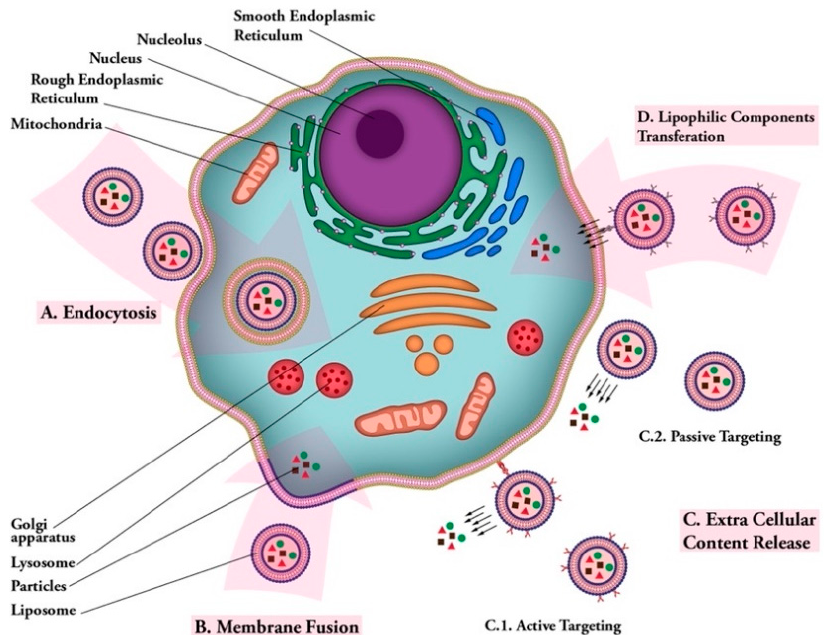
Figure 4. Liposomal vaccine uptake mechanisms. ( A ) Endocytosis: uptake of vaccine carrier by cell; ( B ) membrane fusion: fusion of vaccine carrier and cell membranes and release of vaccine particles into cytoplasm; ( C ) extra cellular content release: ( C.1 ); active targeting: releasing vaccine particles near cell membrane after targeting via ligand-receptor connection. ( C.2 ); passive targeting: release of vaccine particles near cell membrane; ( D ) lipophilic components transferation: transfer of lipophilic vaccine particles through cell membrane after carrier ligand-receptor